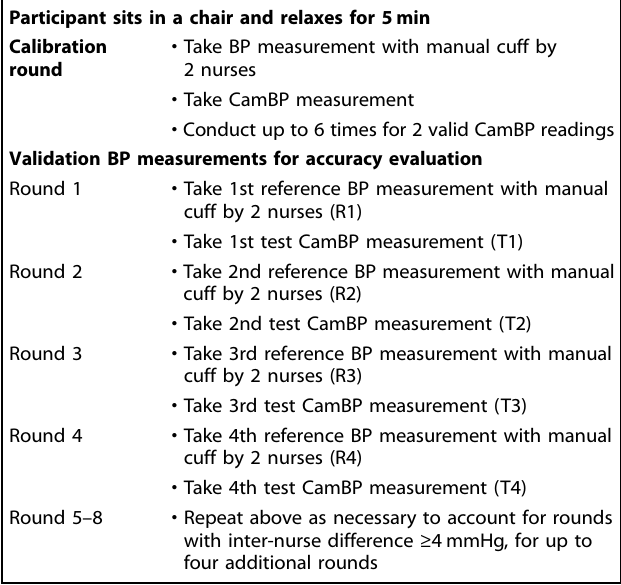
Table 5. Work fl ow for study participation. Participant sits in a chair and relaxes for 5 min Calibration round